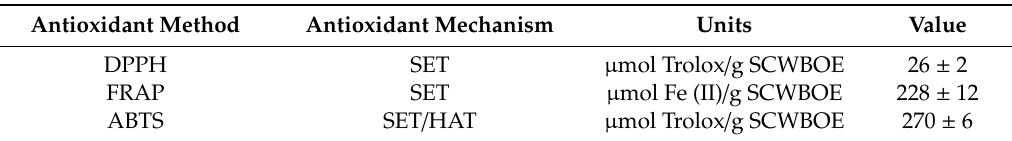
Table 2. Antioxidant profile of the